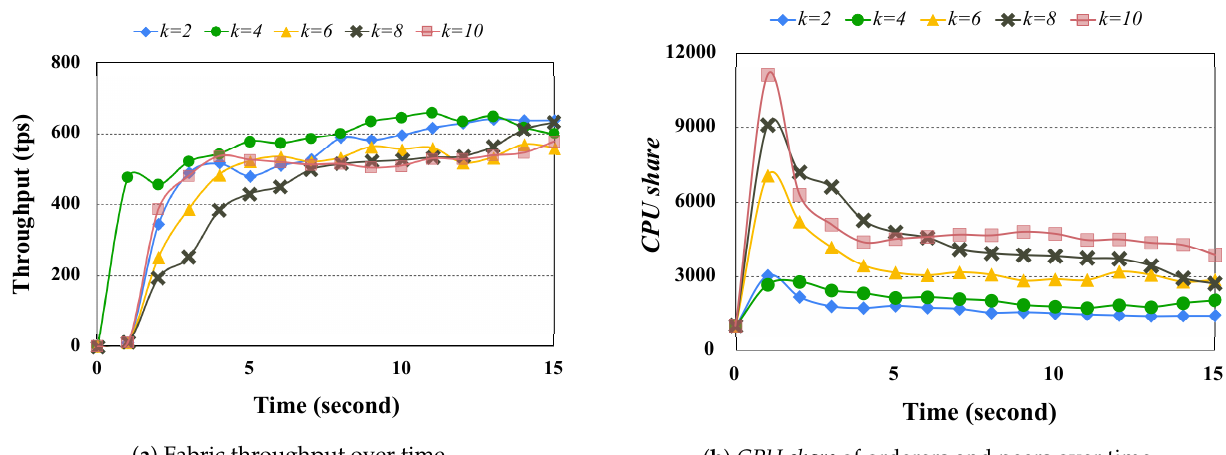
Figure 6. Impact of QiOi algorithm depending on the value of k .